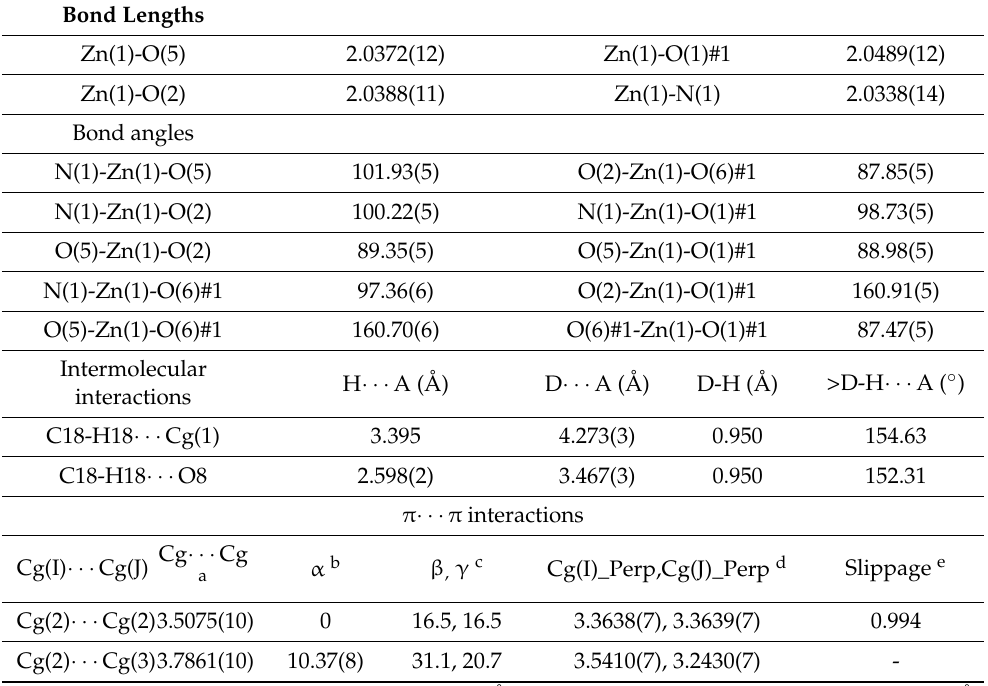
Table 1. Bond lengths (Å), bond angles ( ◦ ) and intermolecular interactions in 1